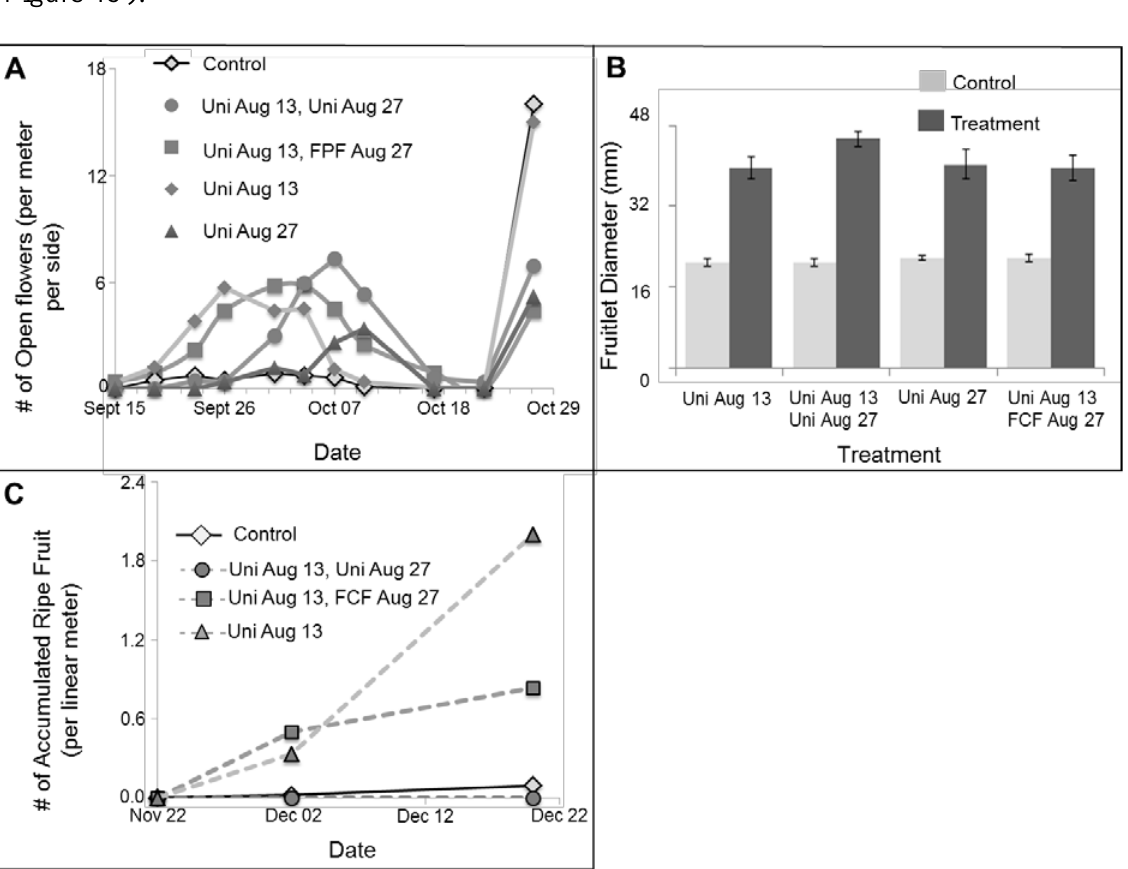
Figure 5. Uni and FCF spray on PD vines in a commercial orchard (2010). Treatments: 200 ppm Uni on August 13/on August 13 and on August 27/200 ppm Uni on August 13 and 10 ppm FCF on August 27/Control (water and surfactant sprayed on August 13). ( A ) Counts of open flowers on several occasions between September 19 and October 27; the latter date is when flowers in the control plants began to reach anthesis. For each date, the average number of flowers reaching anthesis per running meter of trellis per side is presented; ( B ) Fruitlet size (diameter in mms) on November 1: the two largest developing fruits per running meter were documented in each treatment and in the control plants growing in the same orchard line; ( C ) Accumulated number of ripe (abscised) fruits (as in Figure